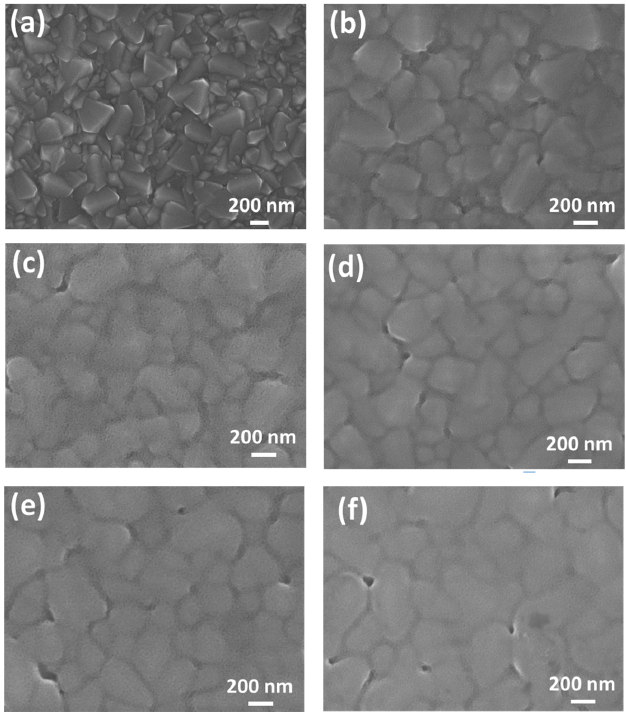
Figure 2. Various ZnO electron transport layers spin-coated on the FTO glass: ( a ) Bare FTO; ( b ) one layer; ( c ) two layers; ( d ) three layers; ( e ) four layers; and ( f ) five layers.